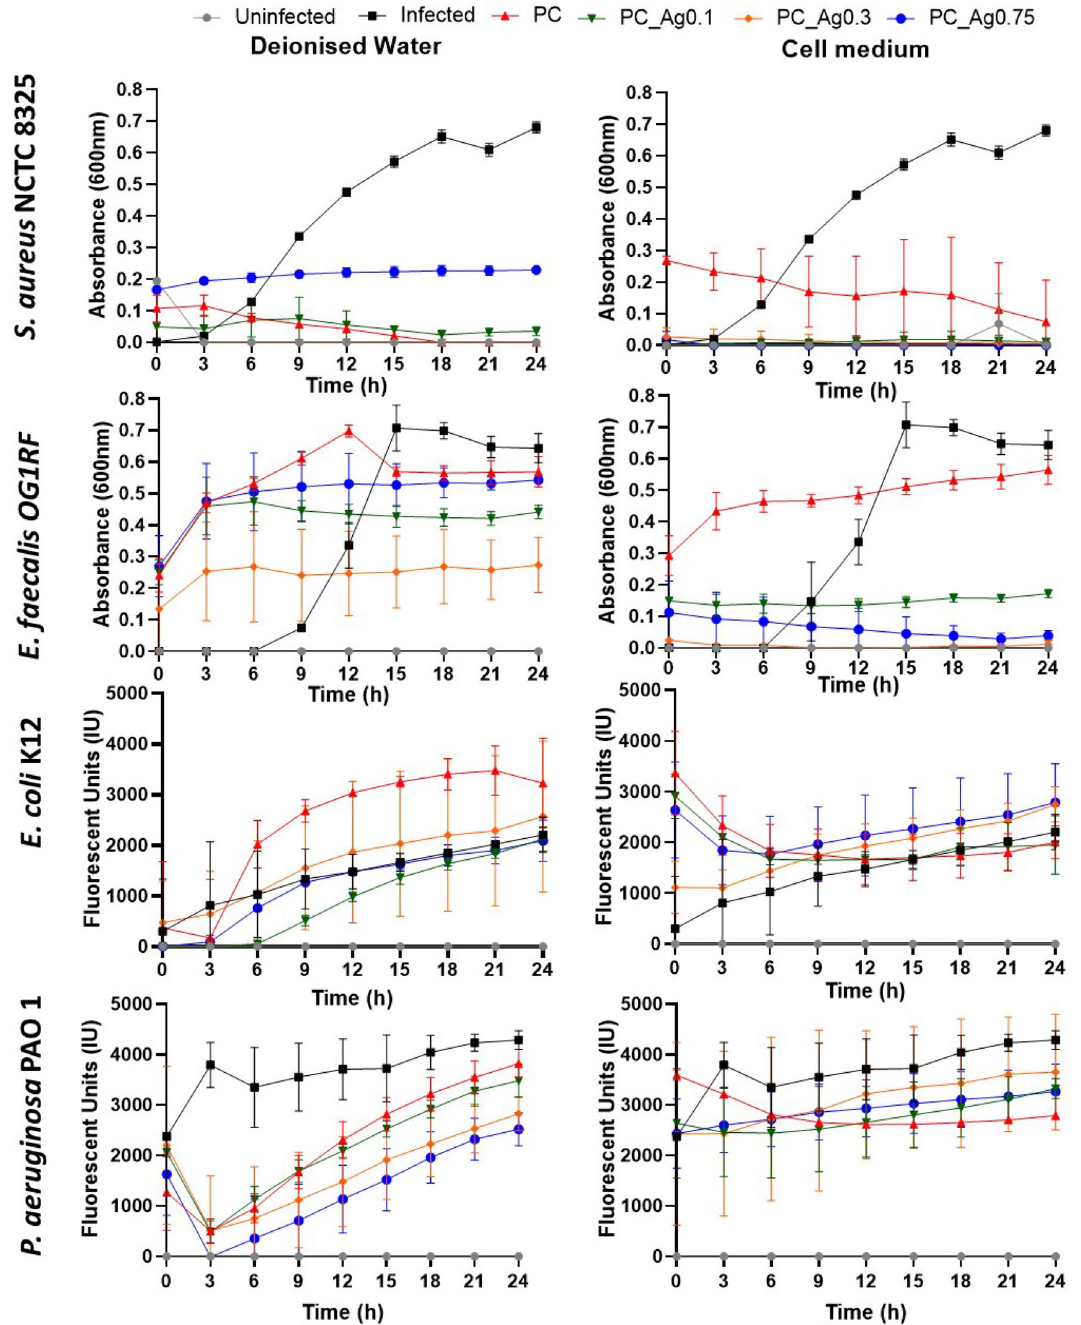
Figure 7. Infection of HaCaT cells with bacterial strains after 24 h incubation with coacervate dissolution products in water and cell medium. A culture of HaCaT cells was used as a control (uninfected). Error bars indicate the mean ± standard deviation (n =